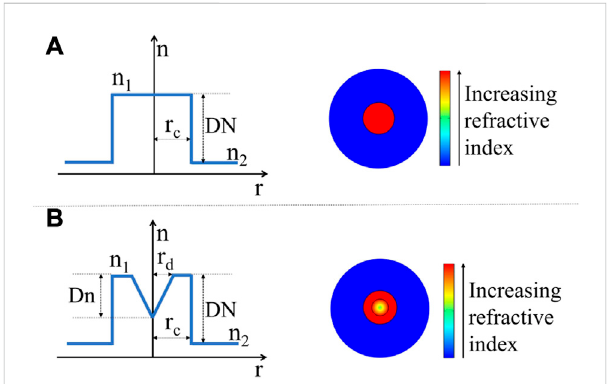
FIGURE 1 Illustration of RI pro fi le of (A) SIF and (B) CDF. The radius of the core and dip region is r c and r d respectively. DN is the RI difference between the core (n 1 ) and the cladding (n 2 ) while Dn is the maximum RI difference in the dip